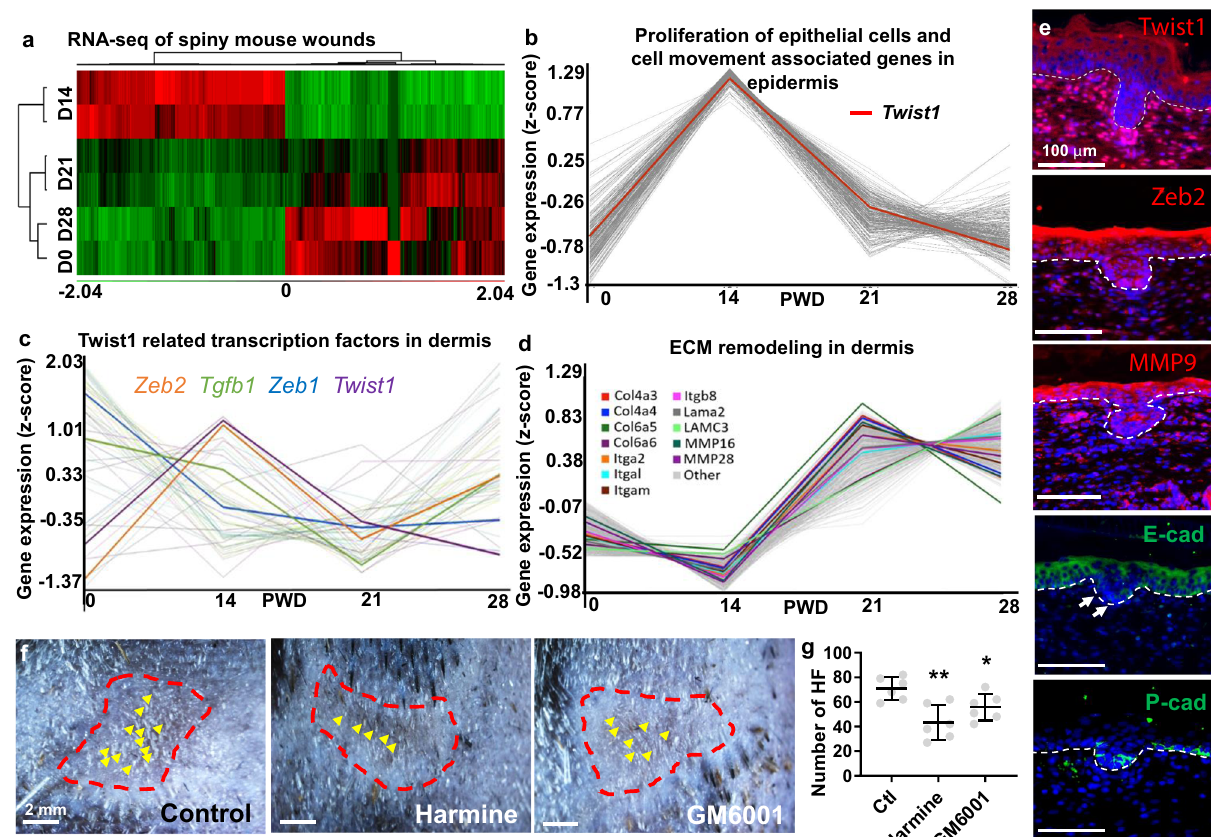
Fig. 4 Twist1 is also expressed and can modulate the outcome of WIHN in spiny mice. a Gene expression heatmap of spiny mouse epidermis at different post-wound days. b Proliferation of epithelial cells and cell movement associated genes in the spiny mouse wound epidermis. c Twist1 related transcription factors in the spiny mouse wound dermis. d ECM remodeling in the spiny mouse wound dermis. e IHC of Twist1, Zeb2, MMP9, E-cad and P-cad in PWD14 the regenerating hair placodes of the spiny mice. White arrows point to the downregulation of E-cad at the tip of hair placode. f The effects of Twist1 inhibitor Harmine and pan-MMP inhibitor GM6001 treatment on hair neogenesis in spiny mouse. Red: wound border; yellow arrow: hair follicles. Observed on PWD35. g Dot graph of the number of regenerated hair follicles (HF) observed in spiny mouse wounds under different treatments. n = 6 biologically independent animals. Data are presented as mean values ± SEM. * p = 0.0265; ** p = 0.0027; unpaired two-sided t -test. Ctl: control. The images in f represent six out of six experiments performed. The images in e represent 4 out of 4 experiments